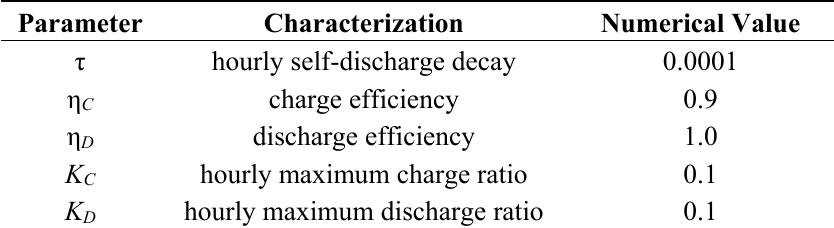
Table 1. Energy storage